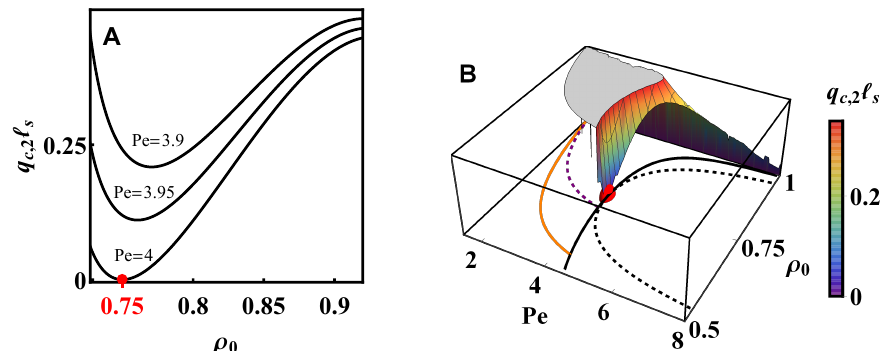
Figure 9: The critical current q , given by Eq. (38), for three Pe values. Panel (A) c ,2 = 3 / 4 upon shows how the critical current (38) vanish at the MIPS critical density ρ 0 approaching the MIPS critical point Pe = 4. (B) The same as (A) but presented in the ( ρ ,Pe, q ) space. The critical current threshold, Eq. (38), vanishes at the MIPS 0 critical point which is marked by the red dot. The black and dashed black lines are the MIPS binodal and spinodal respectively. The orange and purple curves are the → 0 which are given boundaries of the globally and linearly unstable regions at ℓ − 1 s by Eqs. (36) and (37),